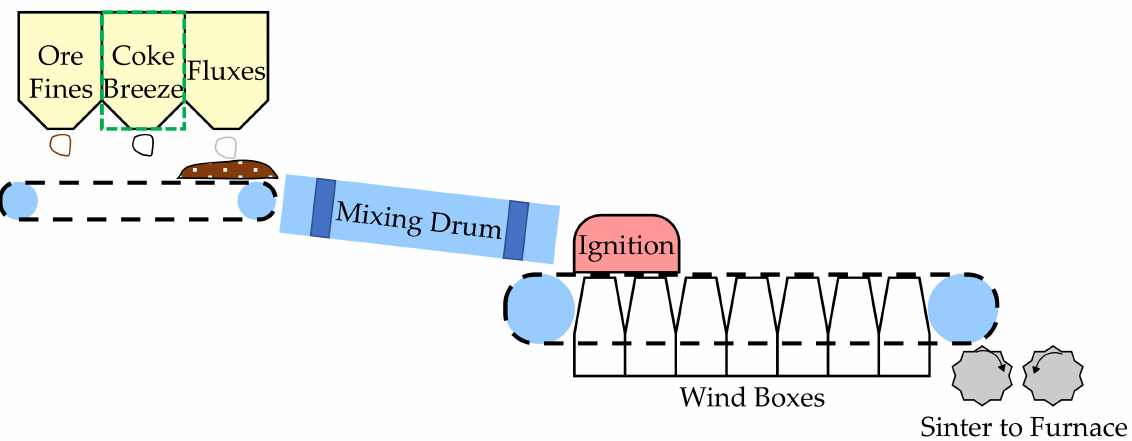
Figure 5. Schematic sintering process.